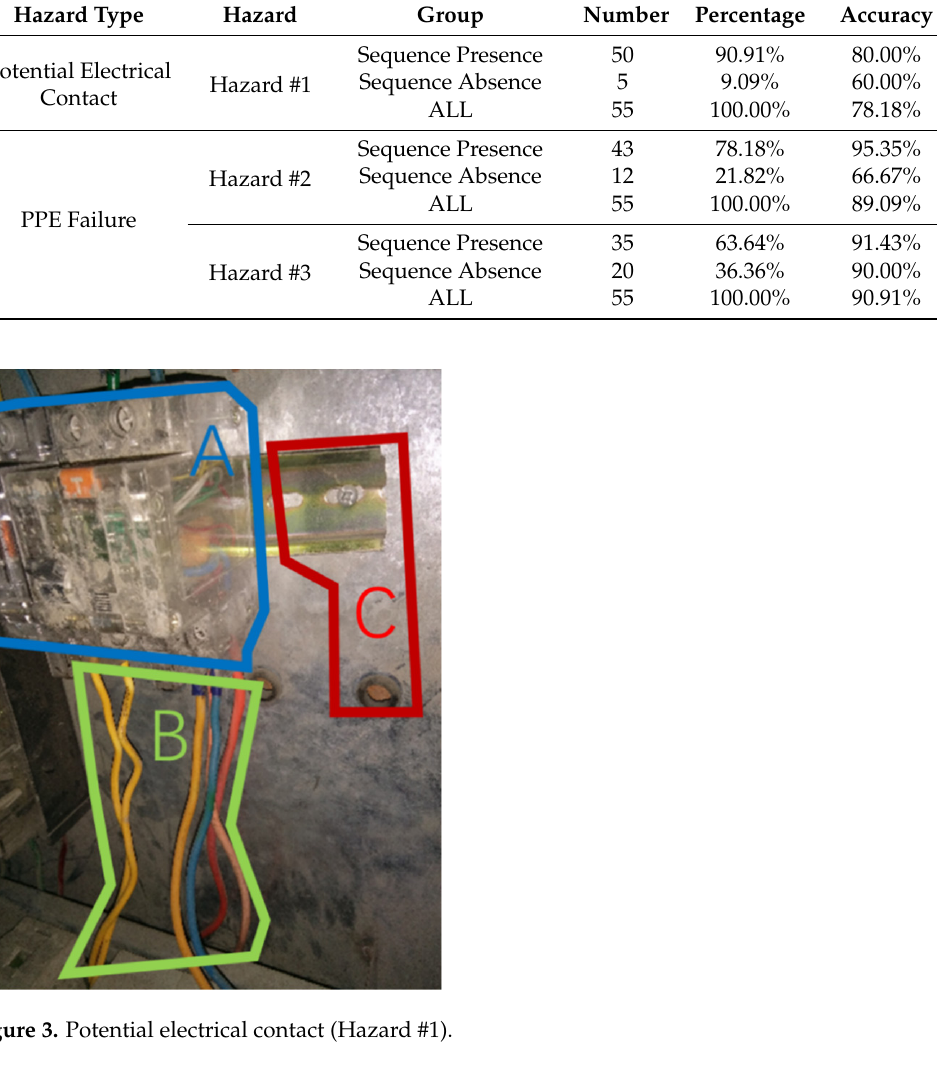
Figure 4. The visual heat map of Hazard #1.